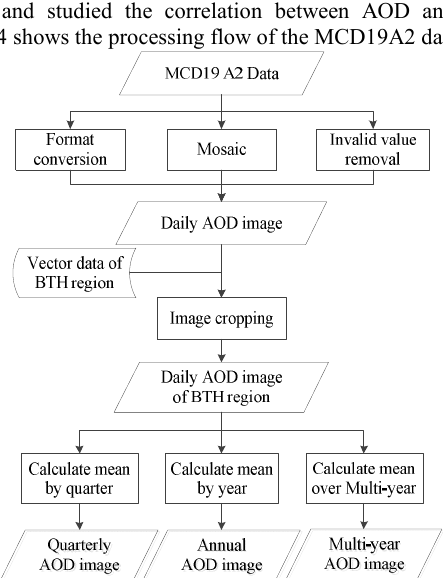
Figure 4. Processing flow of the MCD19A2